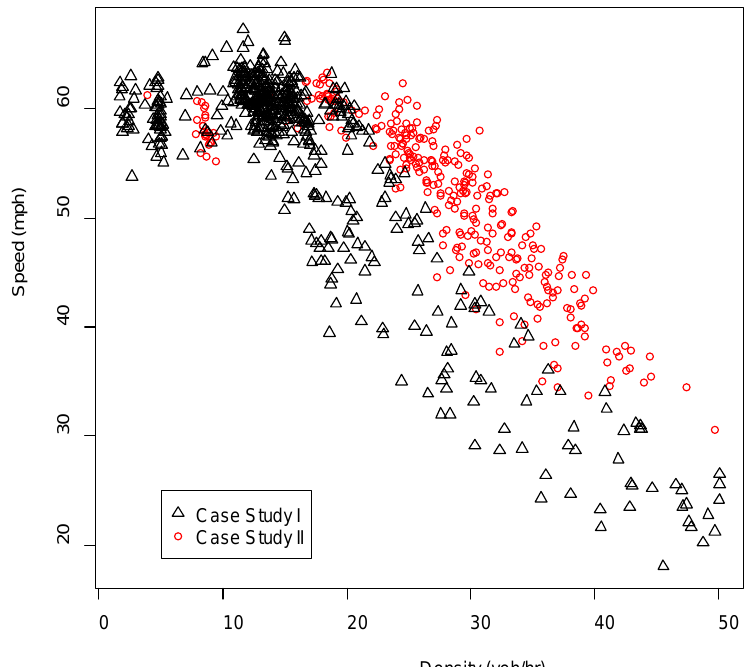
Figure 8. Speed-density plot of case study I and case study